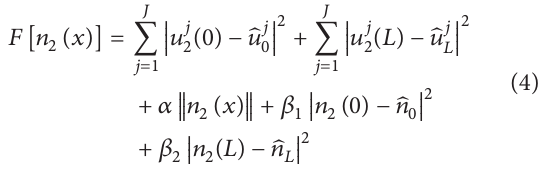
Figure 2: The layer’s transmittance 𝑇 versus frequency 𝜔 . The solid curve corresponds to the discontinuous refractive index, and the red dashed curve is for the continuous refractive